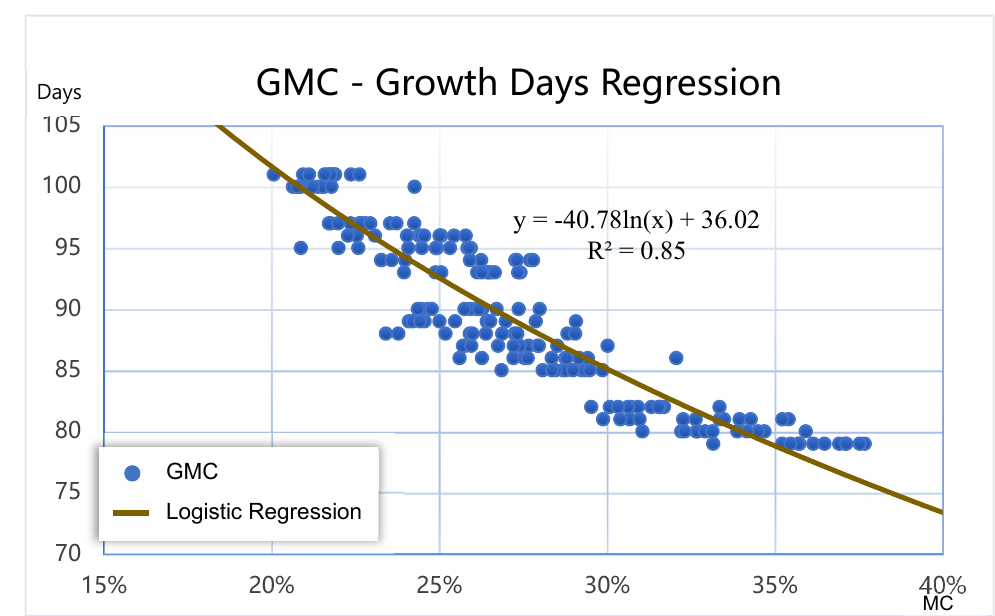
Figure 16. Data distribution and logistic regression of the GMC and growth days. Equation (37) and Figure 17 demonstrate the logarithmic formula through the regres- sion of the growth days and GMC; R 2 was 0.84. The formula for predicting the (cid:1833)(cid:1839)(cid:1829) (cid:3036) i days later, according to this model, can be represented as follows: